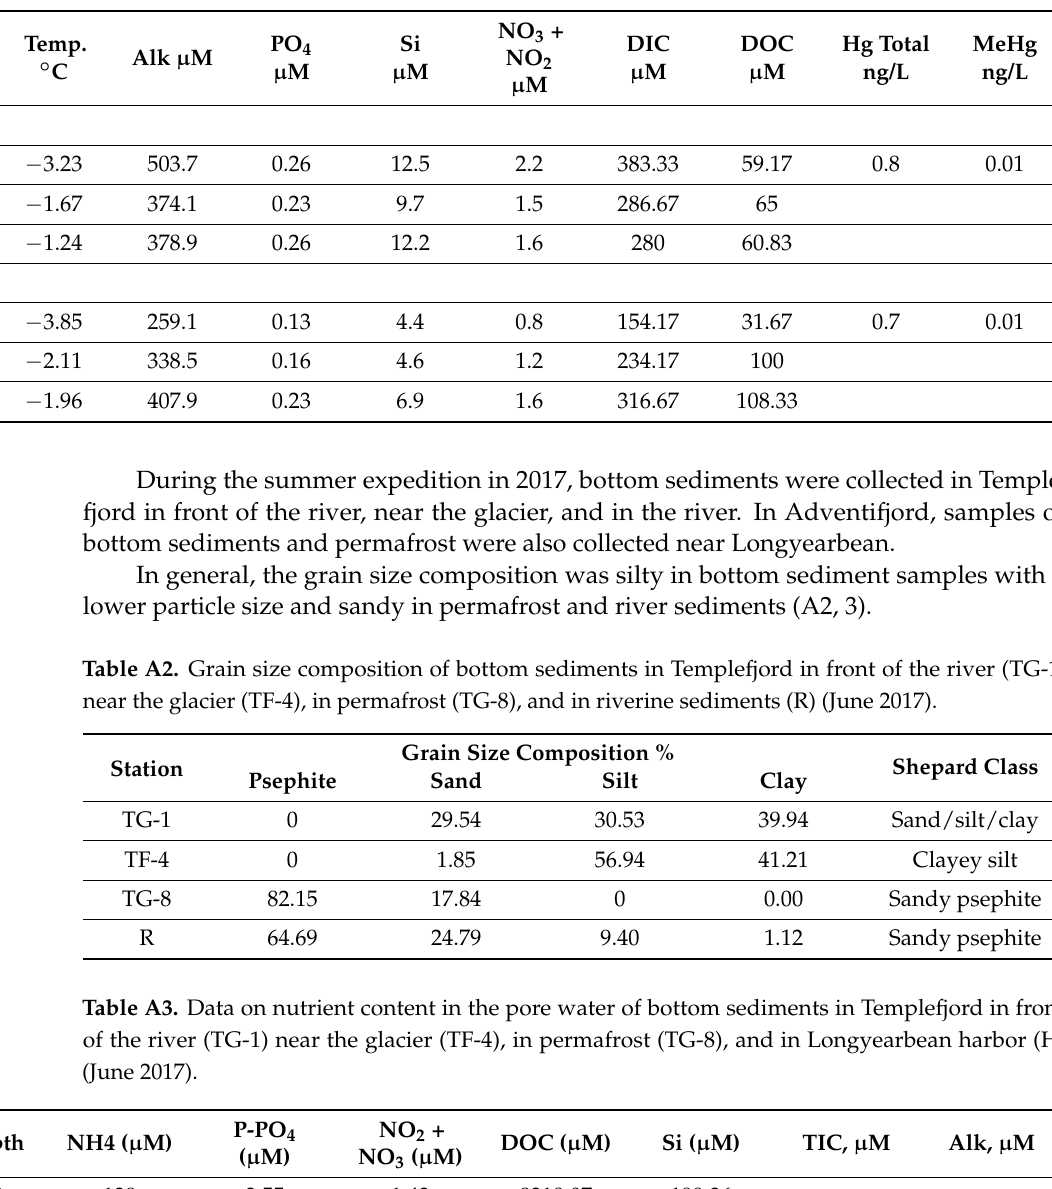
Table A1. Data on the vertical structure of the ice cores on sites TM-1 and TM-2.